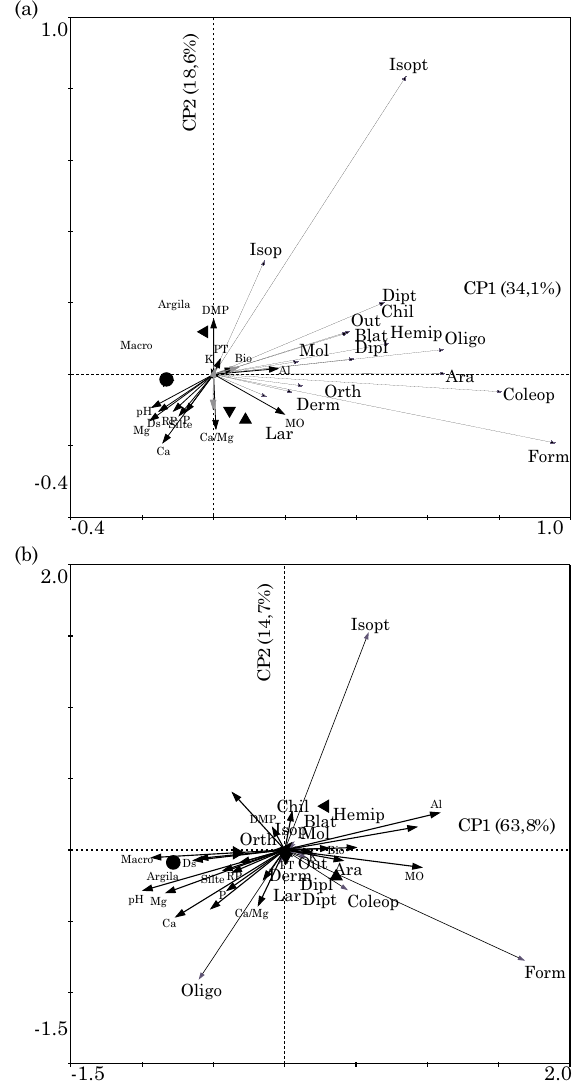
Figura 3. Análise de componentes principais (ACP) no inverno (a) e verão (b) de 2011 para os grupos da macrofauna encontrados e as variáveis ambientais utilizadas como explicativas, na região do Planalto Sul-catarinense. (n = 135). Abreviações: floresta nativa: fn ; reflorestamento de eucalipto: RE